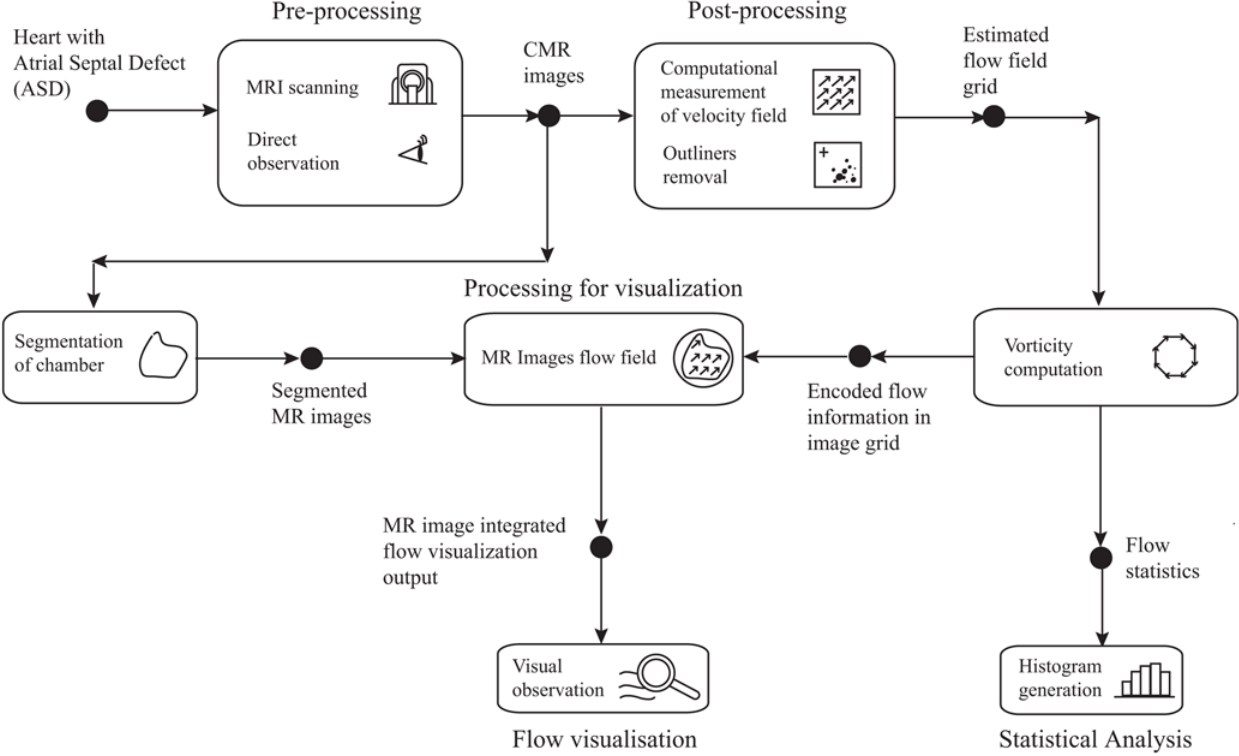
Figure 10. Cardiac vorticity visualization system for ASD investigation. This system is specially constructed to review vorticity characteristics in patients with atrial septal defect (ASD) and relies on computational post-processing of MR images. The vorticity visualization system flow shows data processed by blocks depicting the MR imaging which provides data for generation of flow field flows. Flow visualization is achieved by field display using vector plot with the superposition of MR intensity images. Statistical analysis is supported by histograms of the vorticity maps.